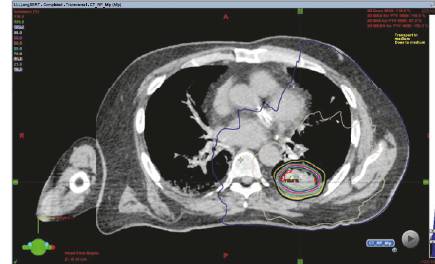
Figure 6: SBRT plan for Patient 2 showing conformal radiation dose delivery to the left pulmonary mass.